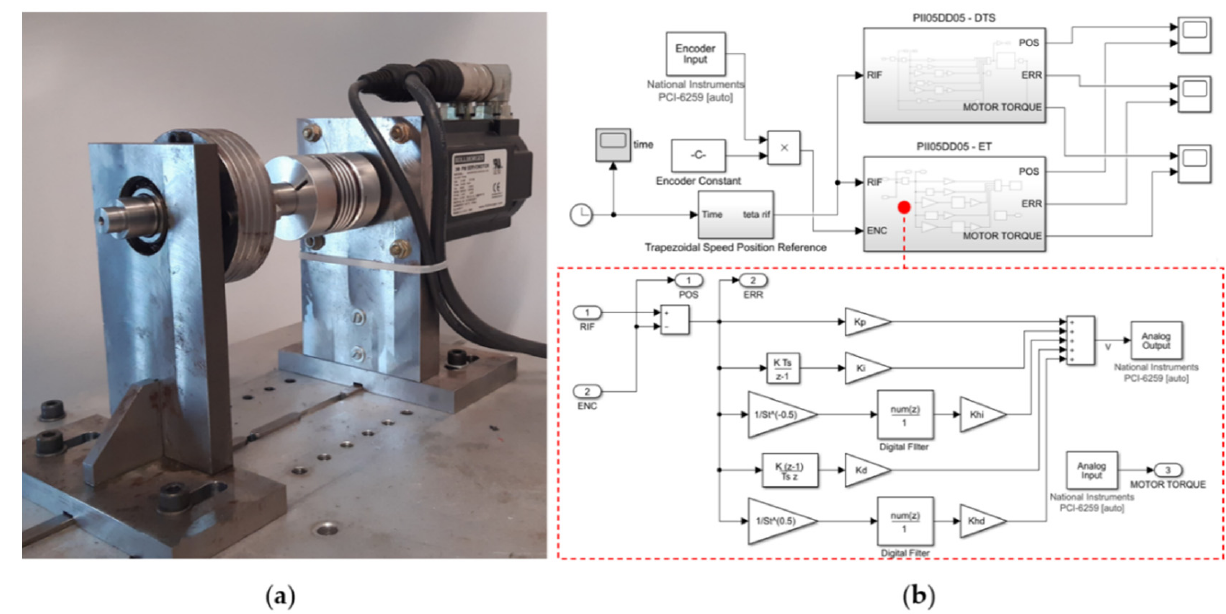
Figure 11. Experimental layout: flywheel directly actuated by the brushless DC motor ( a ) and Simulink Desktop Real Time control scheme ( b ).